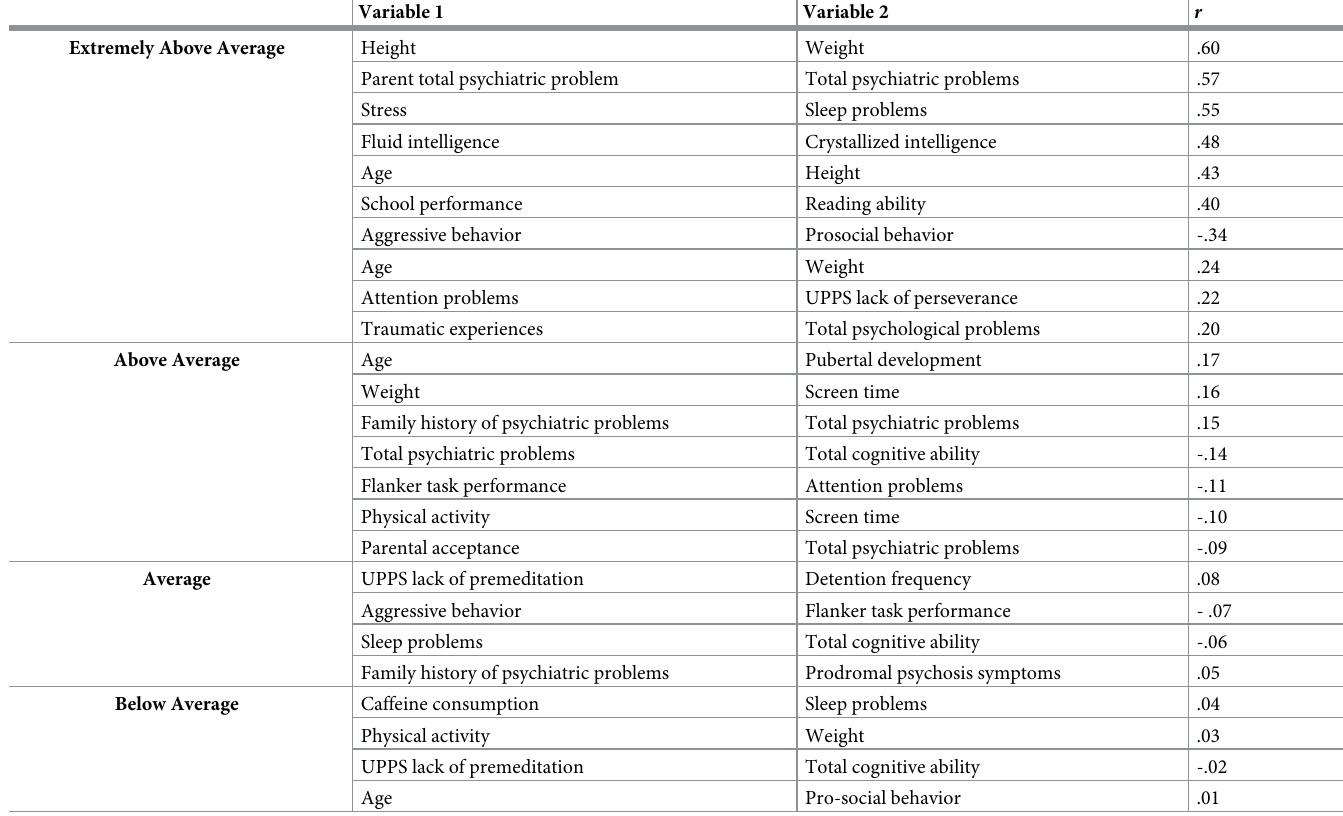
Table 2. Effect size